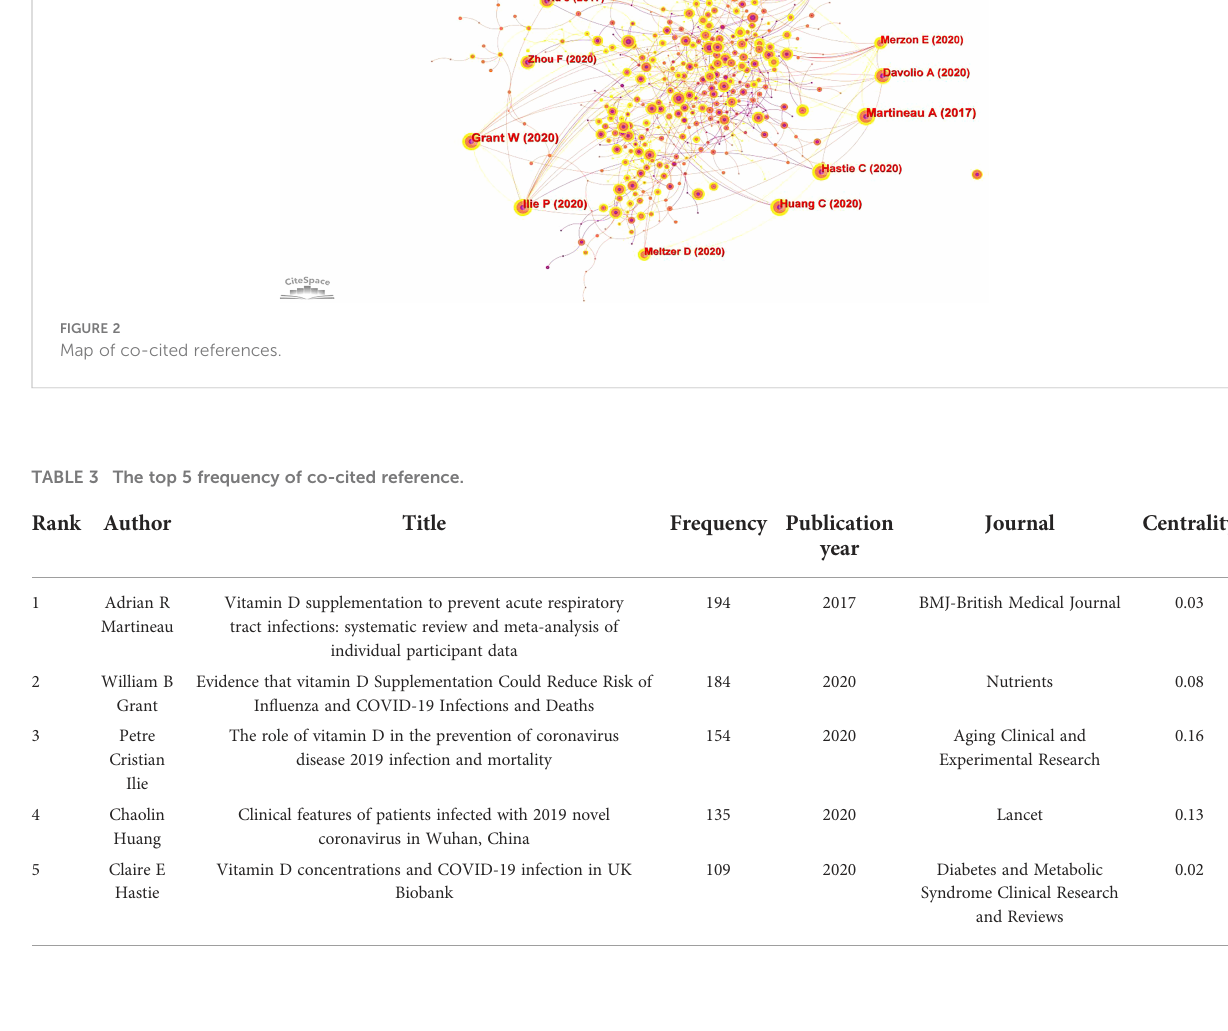
TABLE 4 The top 5 centrality of co-cited